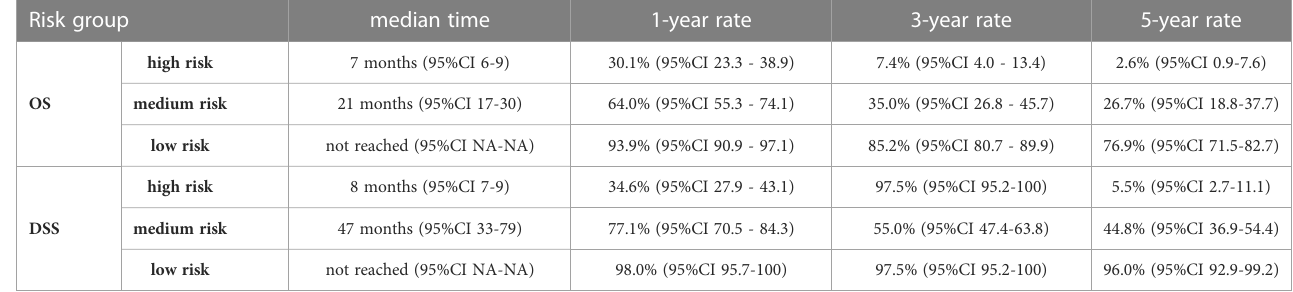
TABLE 4 Risk strati fi cation for the nomogram of OS and